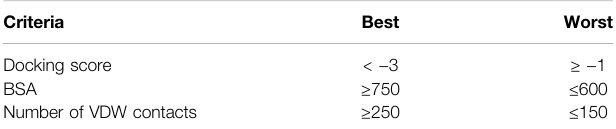
TABLE 3 | Criteria for best and worst docked molecules.